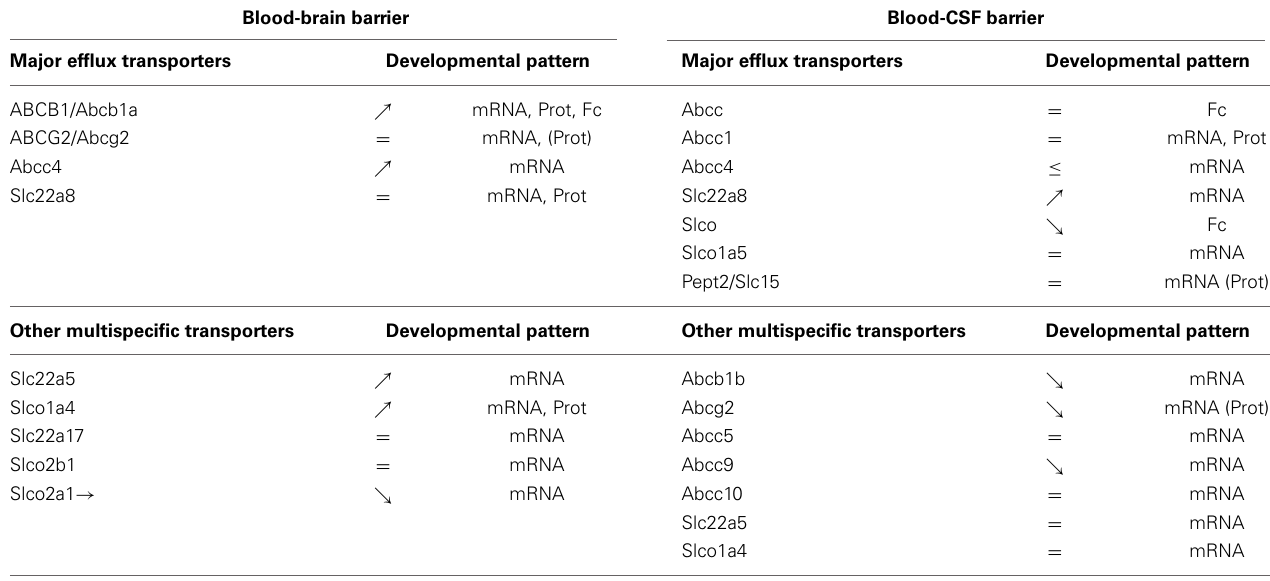
Table 1 | Comparative analysis of the developmental expression pattern of efflux transporters between the blood-brain- and blood-CSF